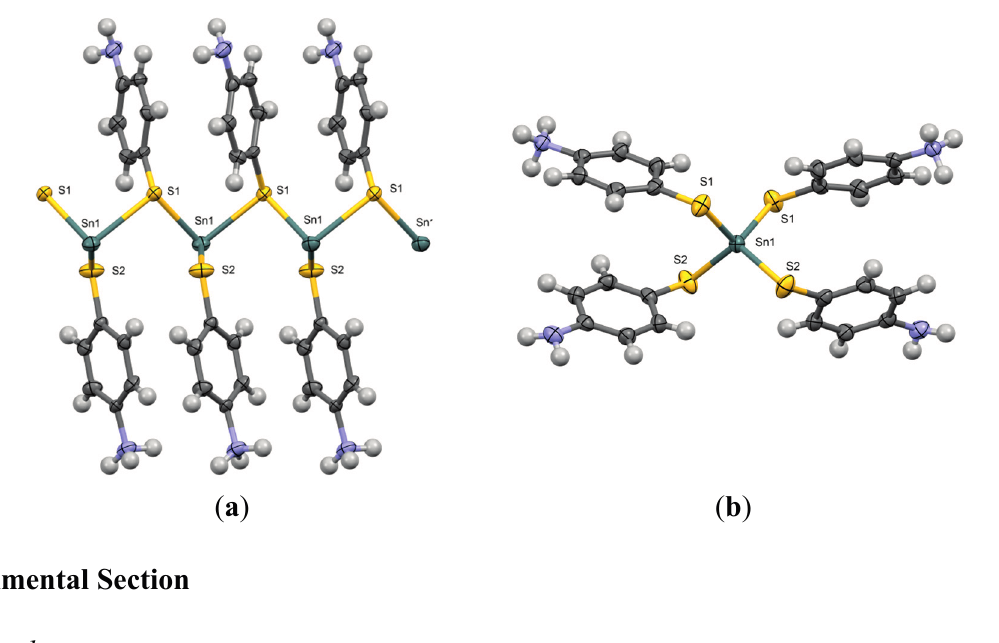
Figure 1. ( a ) ORTEP diagram of Sn (II) containing one dimensional polymer ( 1 ) and ( b ) ORTEP diagram of Sn(IV) containing mononuclear complex ( 2